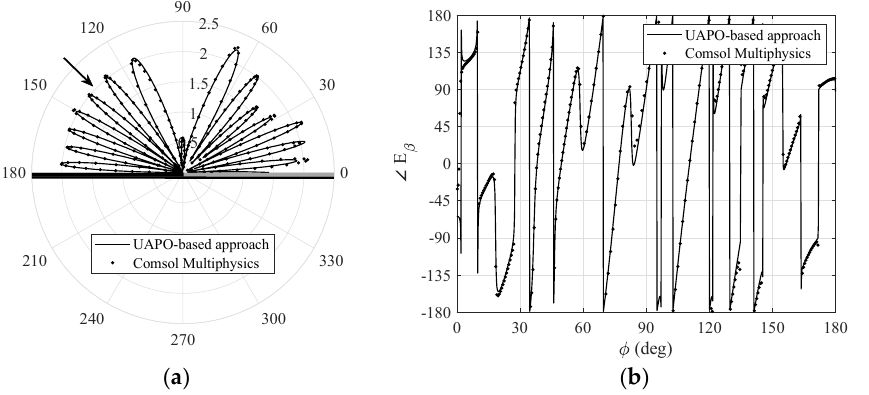
i = 1, E i = 0 . ( a ) = 1, E i = 0. φ (cid:48) β (cid:48) b ' f '